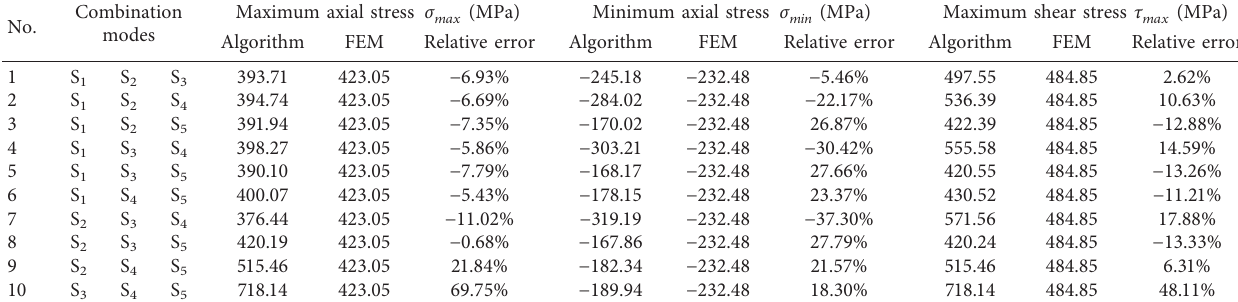
Table 3: Comparison of results between stress algorithm and FEM in pipe section 1.